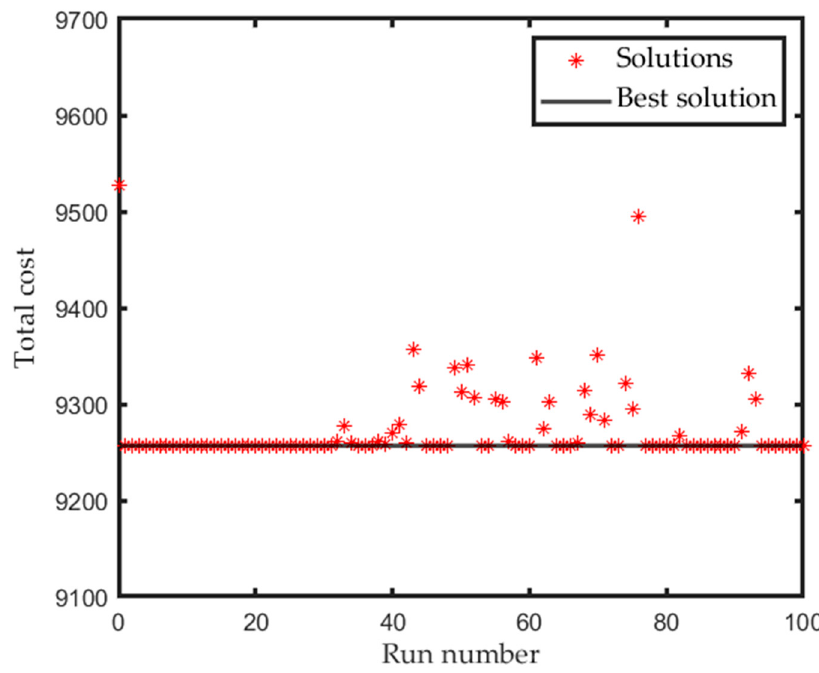
Figure 12. Solution changes for MFO running.